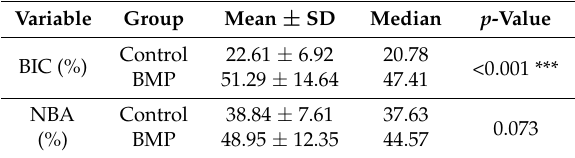
Figure 9. Goldner’s Masson trichrome stain of the histology sections: ( a , b ) Control group; ( c , d ) BMP group. NB : new bone, OB : old bone, S ; scaffold (Original magnification: 12.5× ( a , c ), 50× ( b , d )).